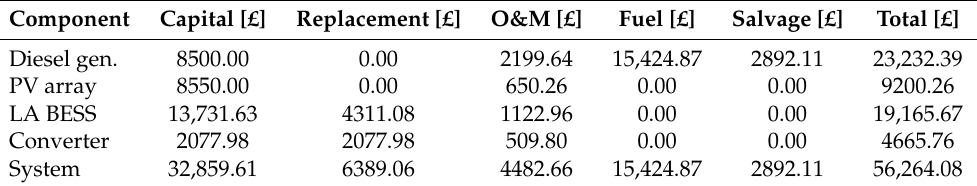
Table 4. Cost summary.